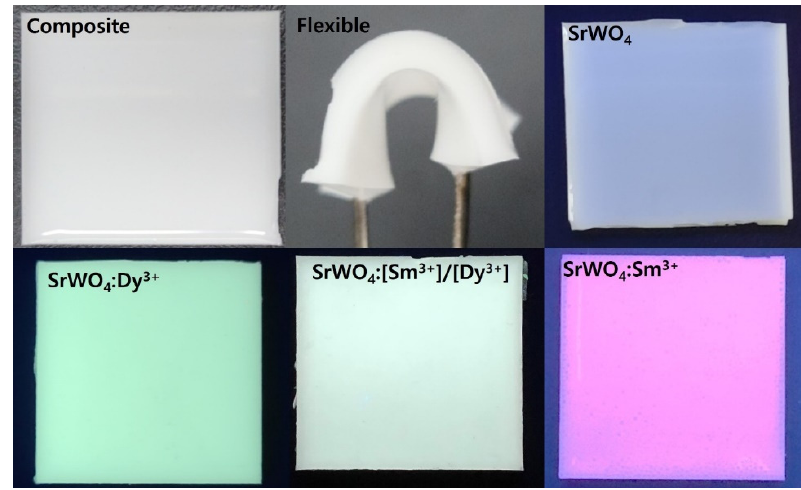
8 of 10 Figure 8. Schematic of energy level structure of the Dy 3+ and Sm 3+ ions.